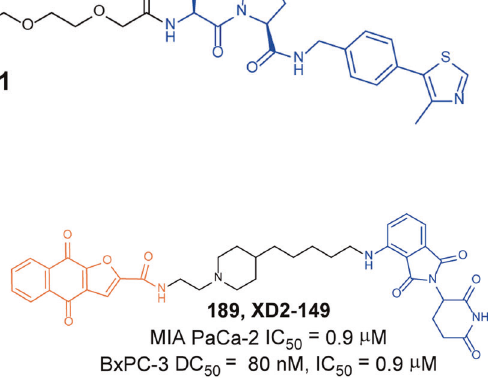
Fig. 52 The representative PROTAC targeting